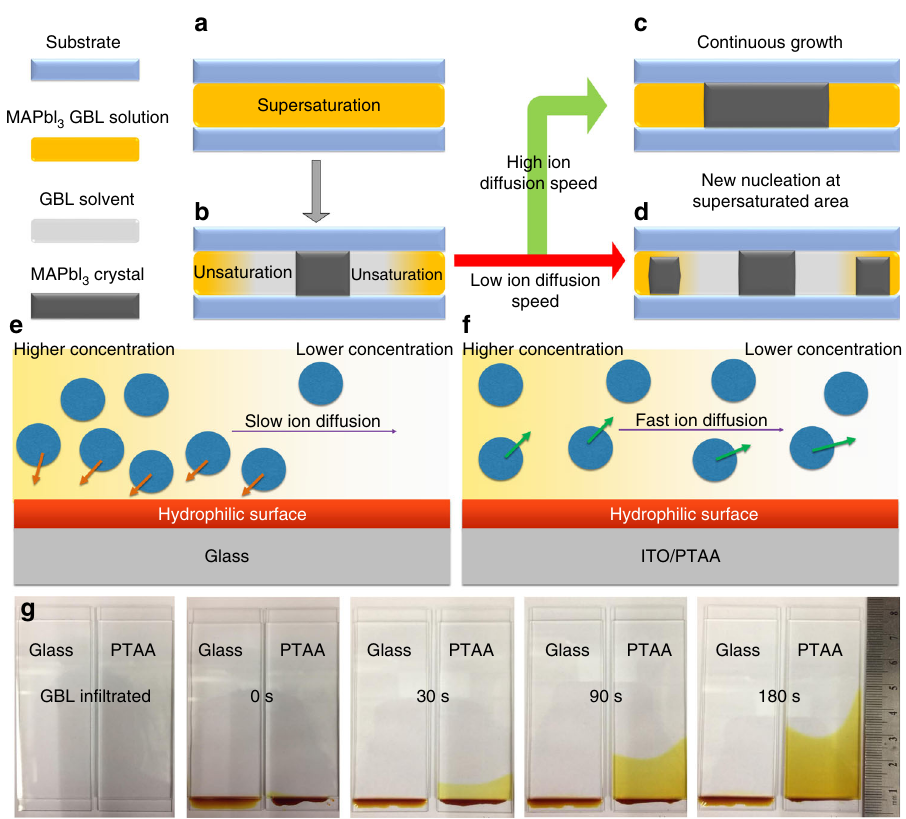
Fig. 2 Growth mechanism of perovskite thin single crystals. a – d Schematic illustrations of correlation between ion diffusion and thin single-crystal growth. Schematic illustrations of ion diffusion rate in the con fi ned gaps using e hydrophilic and f hydrophobic substrates. g Photographs of the diffusion process of methylammonium lead triiodide (MAPbI 3 ) precursor solution in the con fi ned gaps after different durations using hydrophilic glass and hydrophobic PTAA-covered ITO